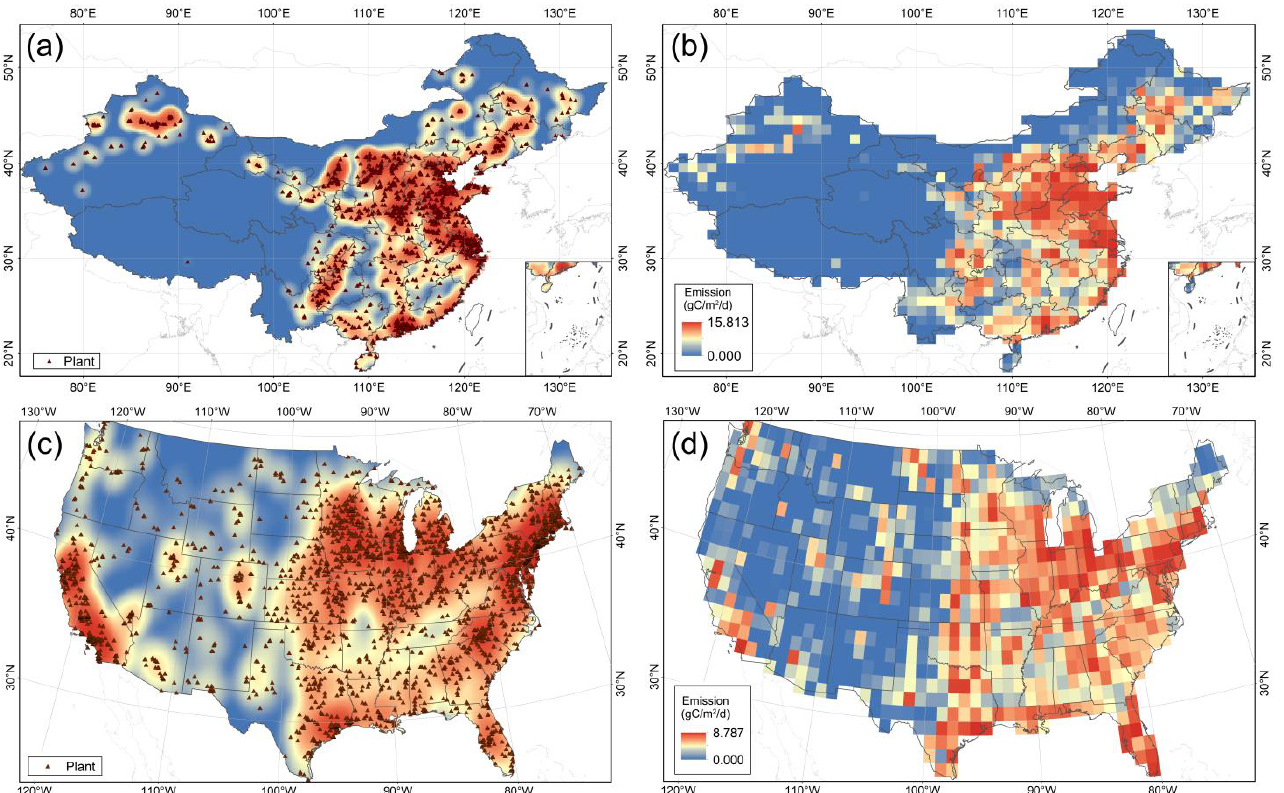
Figure 13. Spatial distribution of ( a ) power plants from GEM with the background of kernel density in Mainland China, ( b ) 1° gridded emission estimates in Mainland China, ( c ) power plants from eGRID with the background of kernel density in the contiguous United States, and ( d ) 1° gridded emission estimates in the contiguous United States.